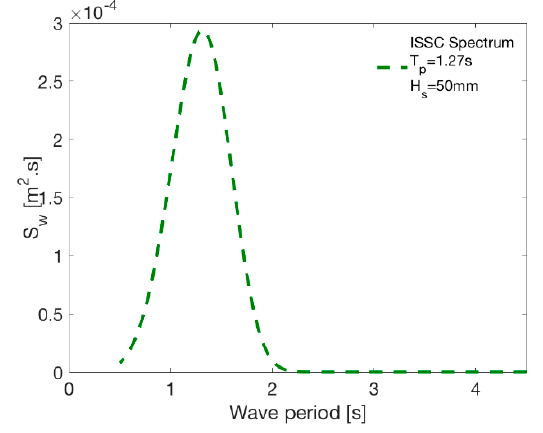
Figure 20. Power spectrum for an operational sea state (cid:1834) (cid:3046) = 50 mm and (cid:1846) (cid:3043) = 1.27(cid:1871) in model scale.